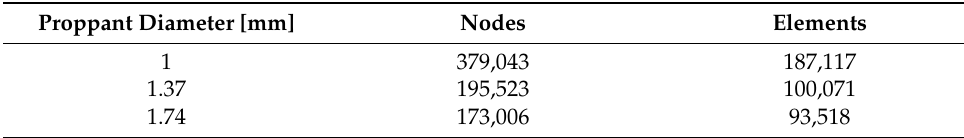
Figure 9. Numerical mesh of the formation ( a ) and proppant particles ( b ) . Table 2. Number of the nodes and